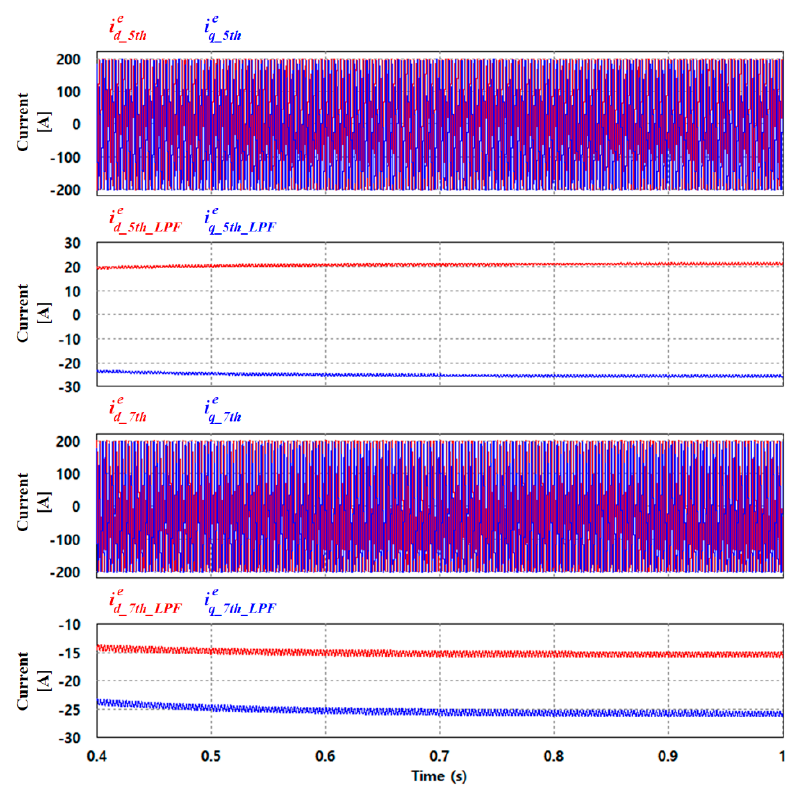
Figure 5. Extracted harmonic currents using the conventional method.